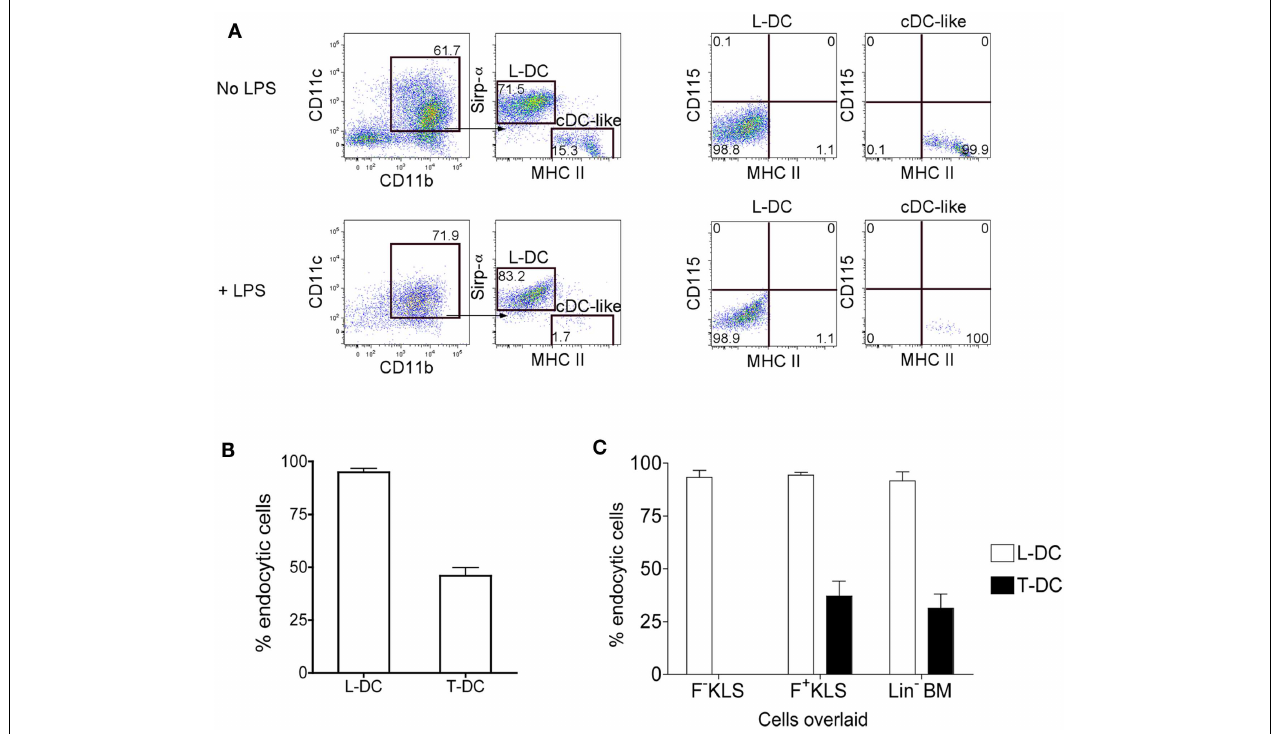
contact), and CD11b + CD11c + MHC-II − cells (L-DC) produced in normal co-cultures (contact). Sorted cells were compared for capacity to endocytose soluble antigen following incubation with FITC-conjugated ovalbumin (FITC-OVA; 2mg/ml) for 45min at 37˚C, or at 4˚C as control. Uptake of FITC-OVA was assessed flow cytometrically in terms of % endocytic cells. Data represent mean ± SE from three independent experiments. L-DC were significantly more endocytic thanT-DC ( p ≤ 0.05). (C) Co-cultures were established with HSC (F − KLS and F + KLS) and Lin − BM, and sorted and analyzed as in (B) . L-DC were significantly more endocytic thanT-DC in all three co-cultures ( p ≤